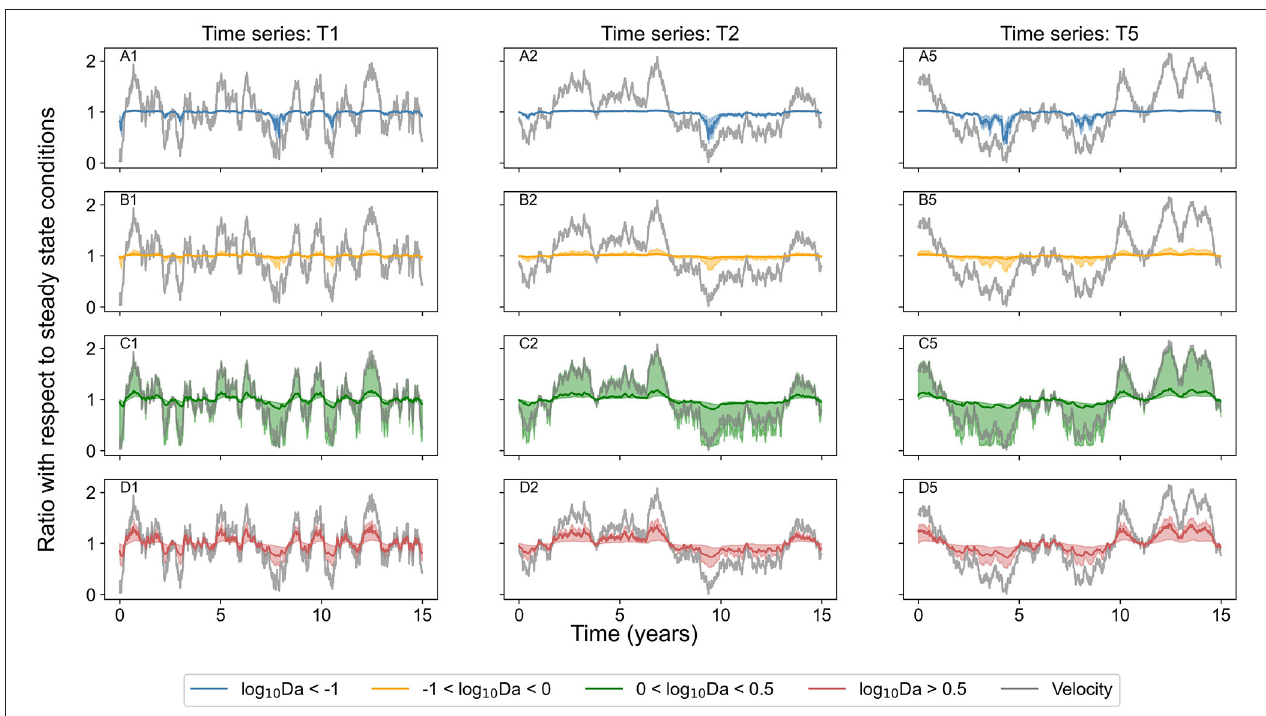
FIGURE 3 | Median concentration of chemical species belonging to identified categories of reaction regimes in all investigated domains bound by 25 and 75% quartile ranges (red for reaction dominant regimes where log 10 Da > 0.5, green for regimes where, 0 < log 10 Da < 0.5, orange for regimes with − 1 < log 10 Da < 0 and blue for reaction-limited regimes with log 10 Da < − 1) over the entire simulation period of 15 years for the three investigated time series (T1, T2, and T5). Velocity normalized by that in steady state conditions is indicated by gray solid line. (A1,A2,A5) Display data for transport dominant regimes in three scenarios (time series T1, T2, and T5) respectively. (B1,B2,B5) Display data for transport influenced regimes in time series T1, T2, and T5 respectively. (C1,C2,C5) Display data for reaction influenced regimes in time series T1, T2, and T5 respectively. (D1,D2,D5) Display data for reaction dominant regimes in time series T1, T2, and T5